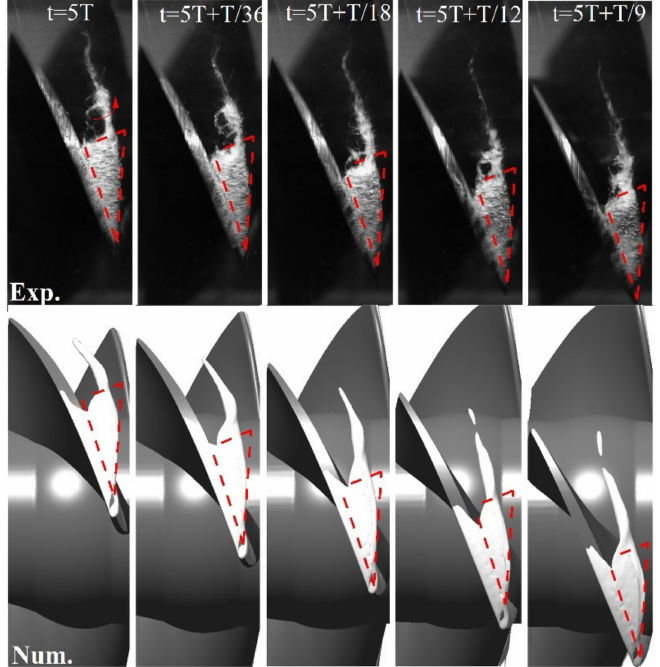
Figure 5. Comparison of the cavitation experiment and numerical calculation results of the axial-flow pump ( σ =